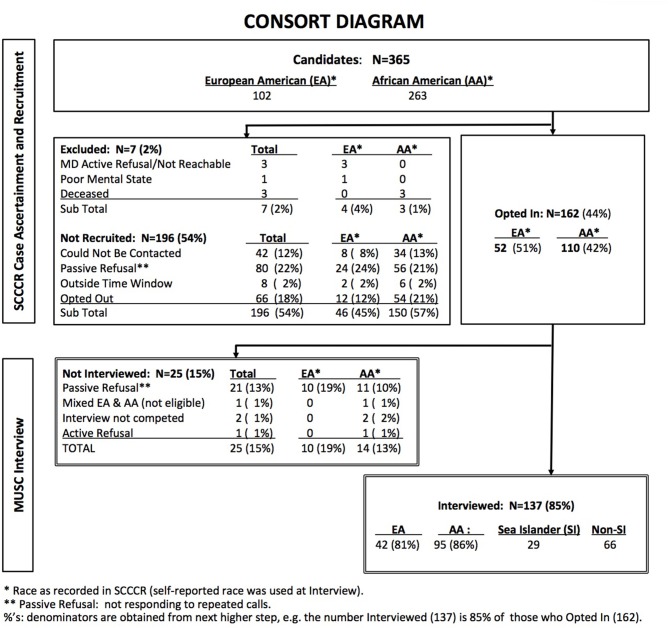
CONSORT diagram.